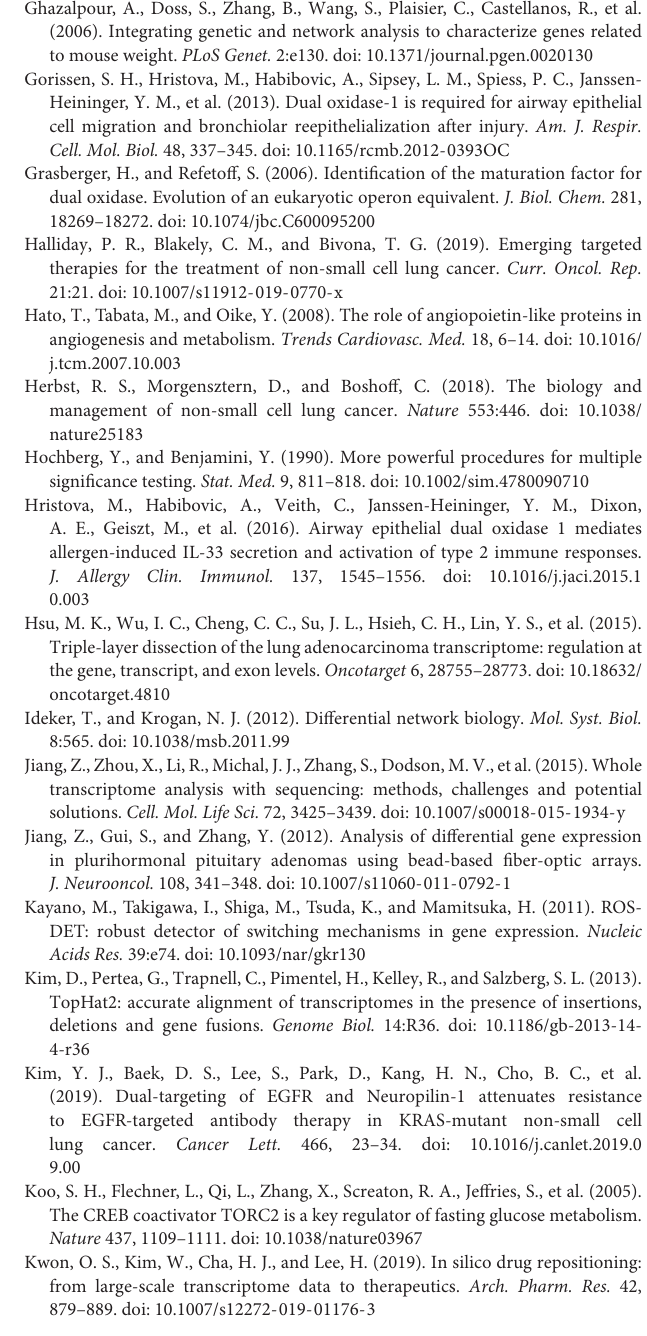
correlation and P -value. The table was color-coded by correlation according to the color legend. Supplementary Figure 2 | A scatterplot of Gene Significance (GS) for Disease vs. Module Membership (MM) in the yellow (A) and mediumorchid (B) modules. There was a highly significant correlation between GS and MM in the module. Supplementary Table 1 | The TCGA sample IDs and their clinical information. Supplementary Table 2 | Primer sequences of GAPDH, ATP13A4-AS1, HIGD1B, DAP3, and ISG20L2.